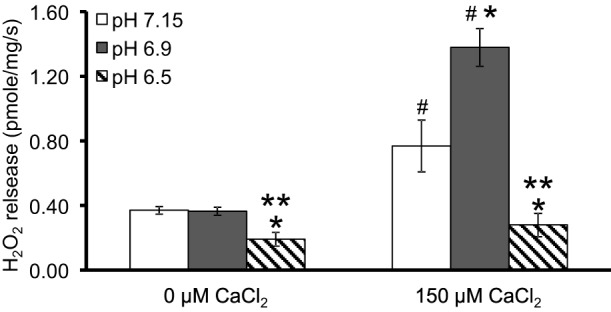
Summary of the effects of pH and added CaCl2 on H2O2 release rates in pyruvate-energized mitochondria after inhibiting complex I with ROT. Columns represent mean values ± SEM of pmol H2O2 emission/mg/s. P < 0.05 *Significant difference in H2O2 release rate at pH 6.9 or pH 6.5 vs. pH 7.15 within the same CaCl2 group. **Significant difference in H2O2 release rate at pH 6.5 vs. pH 6.9 within the same CaCl2 group. #Significant difference in H2O2 release rate in 150 μM CaCl2 vs. 0 μM CaCl2 for each pH group. N = 4 each.